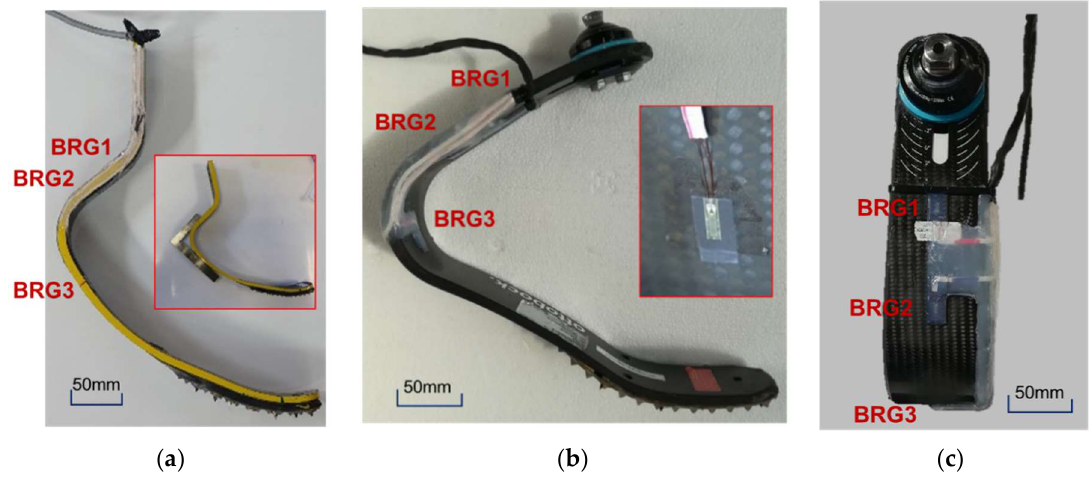
Figure 5. Development of the instrumented RPF: ( a ) strain gauge bridges applied to the J-shaped Cheetah Xtreme Cat. 5 RPF, with a detailed example of the relative position between bridge nr. 3 and bridges nr. 1 and 2; ( b ) side view of Ottobock Runner Cat. 4 RPF, with a detailed view of the applied strain gauge over the carbon fiber laminate; and ( c ) strain gauge bridges applied to C-shaped Ottobock Runner Cat. 4 RPF.